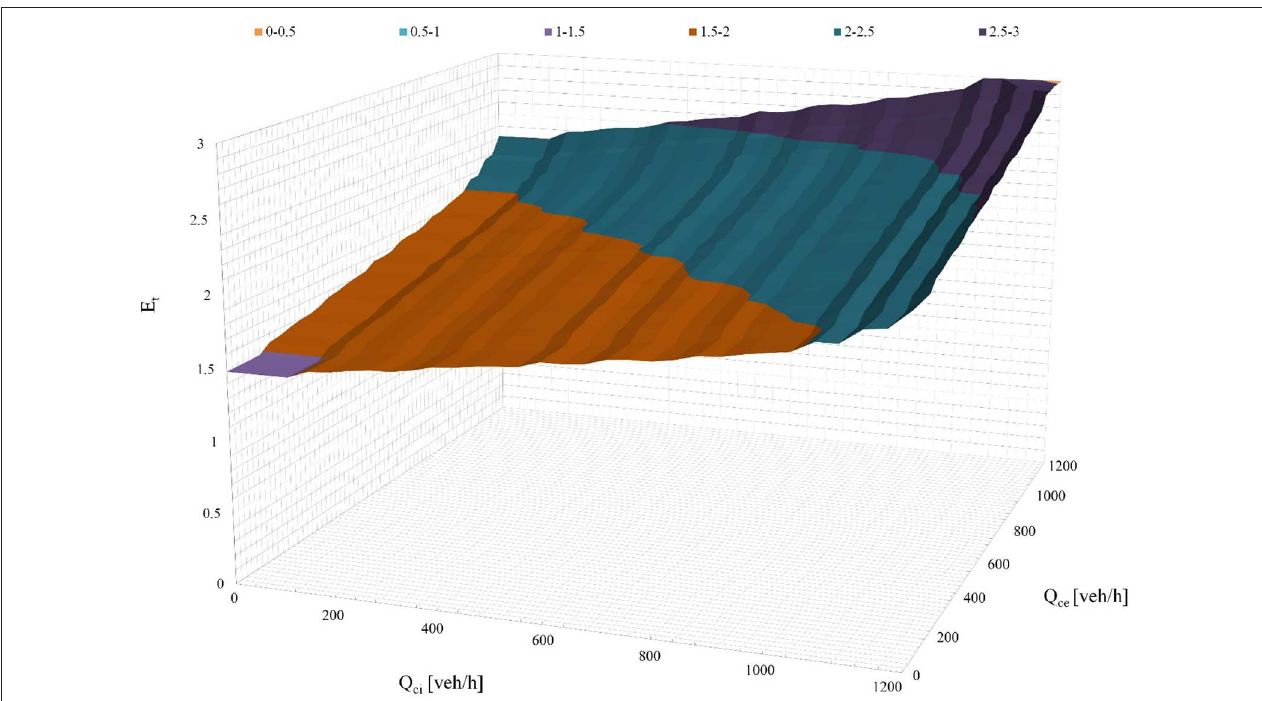
FIGURE 13 | PCE estimations for percentage of heavy vehicles of 20% for left lane at roundabout 2 (minor entries). E t , equivalent factor; Q ce , circulating flow on the outside lane [veh/h]; Q ci , circulating flow on the inside lane